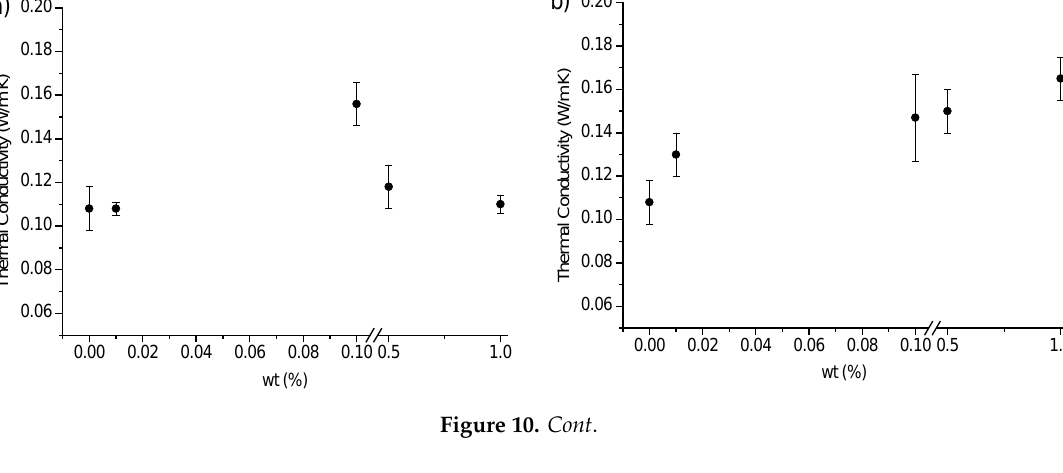
Figure 10. Thermal conductivity of UV-LED cured EB150 and its composite films as a function of filler loading: ( a ) with MWCNTs, ( b ) with biochar and ( c ) with biochar/MWCNTs. Different trends can be observed, according to the filler type and loading. The thermal conductivity data clearly shows a different effect provided by MWCNTs and by biochar. More specifically, the addition of increasing amounts of MWCNTs increased the thermal conductivity that reached a maximum corresponding to 0.10 wt % loading; then, for higher filler loadings, it monotonically decreased. Conversely, the addition of biochar to the UV-curable system determined a monotonically increase of the thermal conductivity, which approached 0.165 Wm − 1 K − 1 for the highest filler loading. Clustering phenomena occurring with increasing the nanofiller concentration might explain the trend of the thermal conductivity of the films containing MWCNTs: these phenomena have already been observed in FESEM analyses. The latter have also pointed out that biochar shows a very homogeneous dispersion within the polymer network, irrespective of its loading: as a consequence, the thermal conductivity shows a monotonic increasing trend. Finally, the concurrent presence of the two carbon fillers was affected by the different morphology of biochar and MWCNTs in UV-LED cured EB150. In particular, at low fillers loadings, the prevailing effect is exerted by biochar, so that thermal conductivity increases; then, the worse dispersion and clustering tendency of MWCNTs becomes predominant and the thermal conductivity significantly decreases approaching that of unfilled EB150 [28]. 3.3.2. Optical properties The transmittance over a wide wavelength range of self-standing composite films was evaluated, assessing the effect of the different fillers and of their loadings on the optical properties of UV-LED cured blank counterparts. To this aim, UV-Vis spectroscopy measurements were performed; the obtained data are shown in Figure 11a–c.